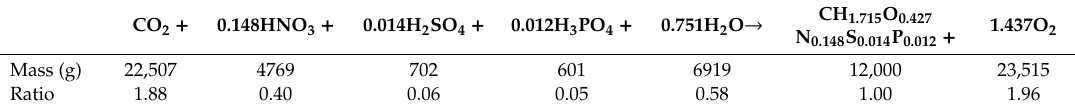
Table A5. Microalgae biomass stoichiometry at ORP process [7].